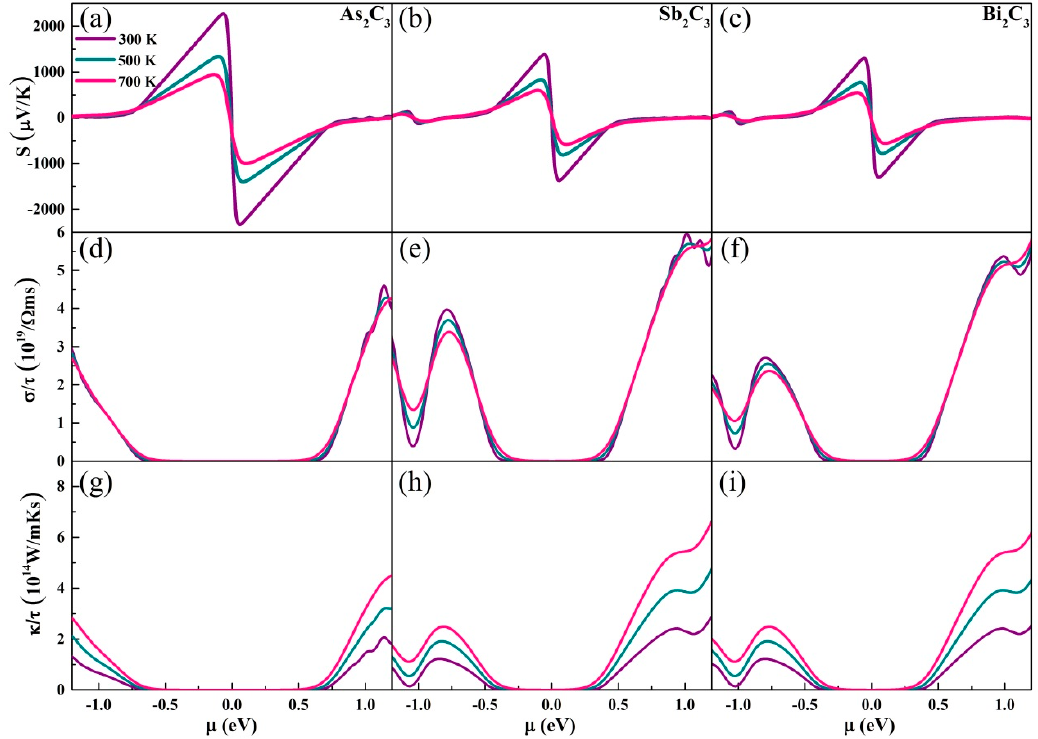
Figure 2. ( a – c ) Seebeck coefficients, ( d – f ) electrical conductivity, and ( g – i ) electronic thermal conductivity with respect to the scattering time at different